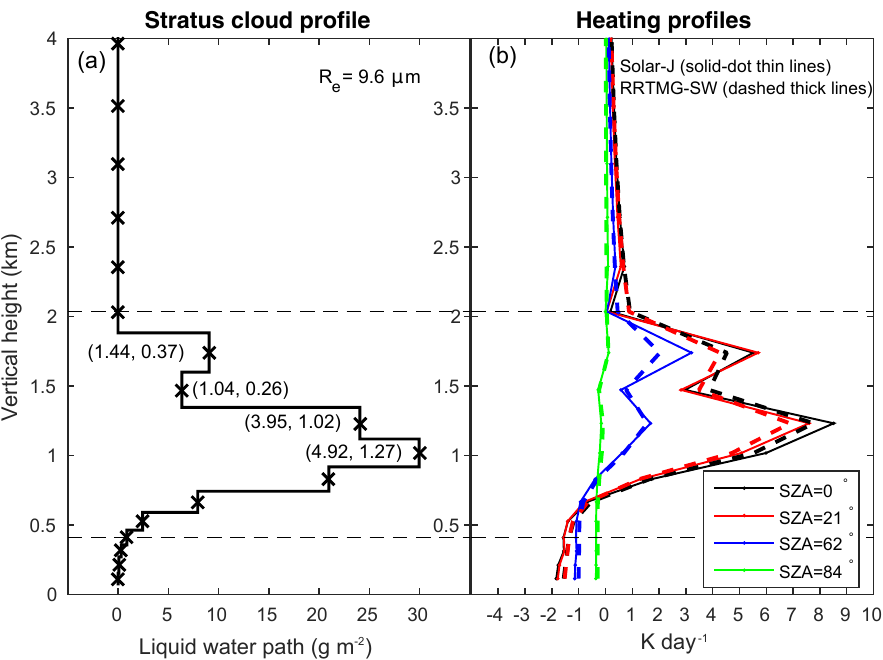
Figure 4. (a) Marine stratus cloud profile in terms of liquid-water path (LWP, gm − 2 ) and effective radius ( r e ,µm). The optical depth and delta-scaled optical depth ( τ , τ (cid:48) ) are shown in parentheses for the top five cloud layers. (b) Cloud heating profiles from Solar-J (solid lines) and RRTMG-SW (dashed lines) at four